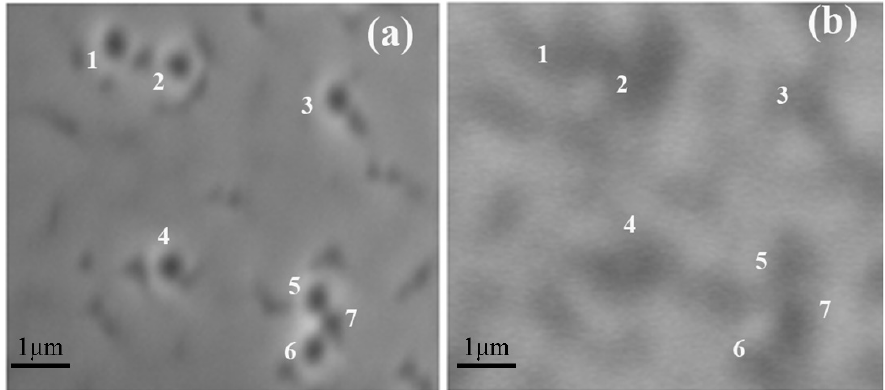
Figure 5. SEM images of the sample B: ( a ) Surface morphology of the InAlN; ( b ) Monochromatic CL mapping of the InAlN.